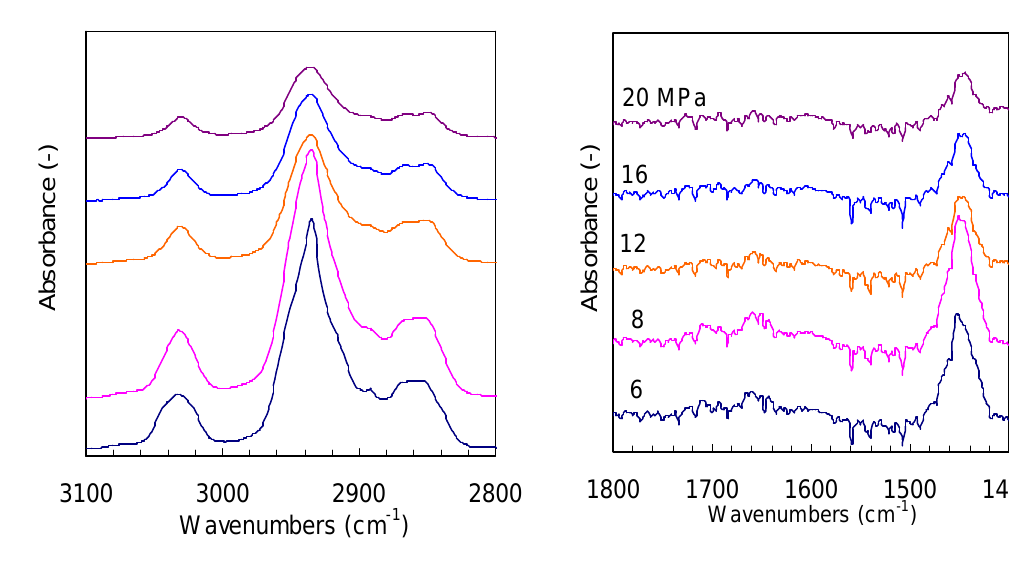
given and at 387